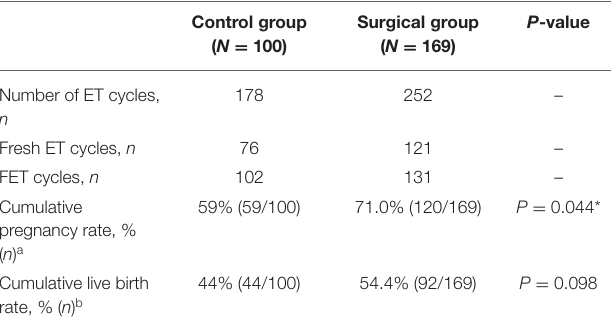
TABLE 5 | Cumulative reproductive outcomes from one complete ART cycle including fresh and frozen-thaw ETs. Control group ( N =